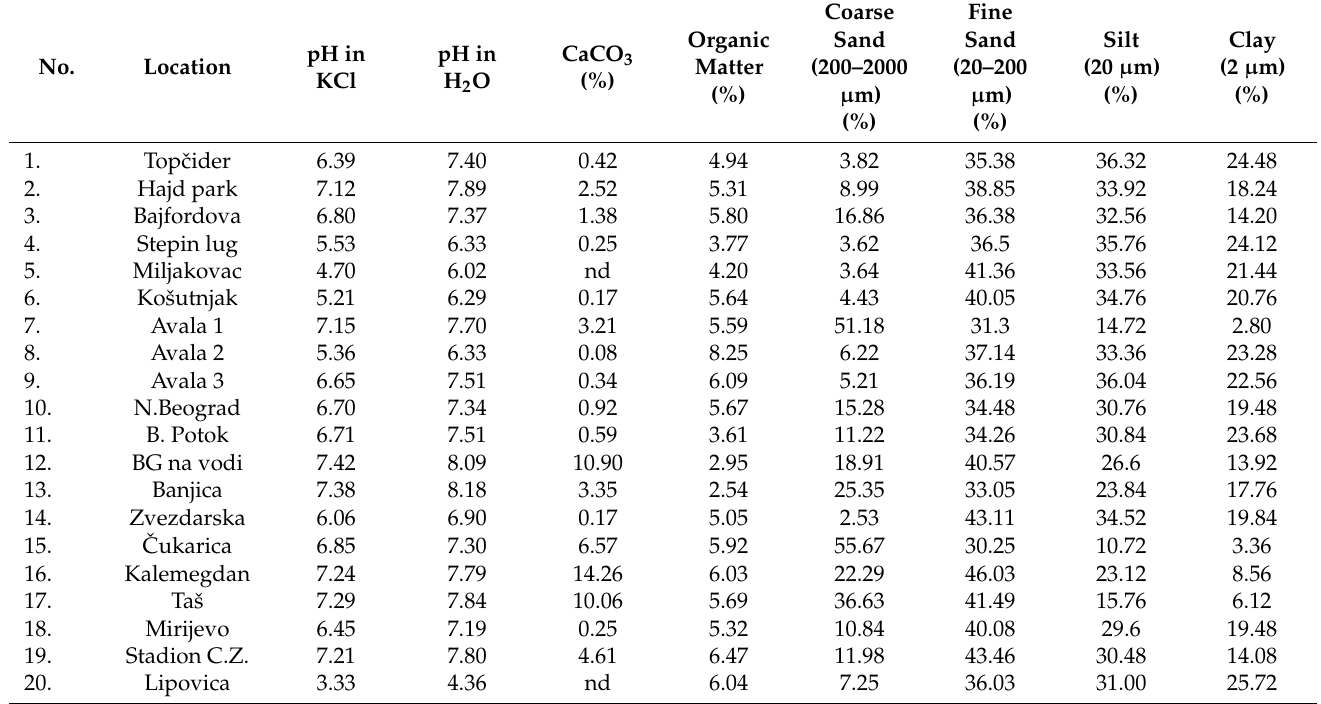
Table 1. Main chemical and physical characteristics of the soil (nd—not